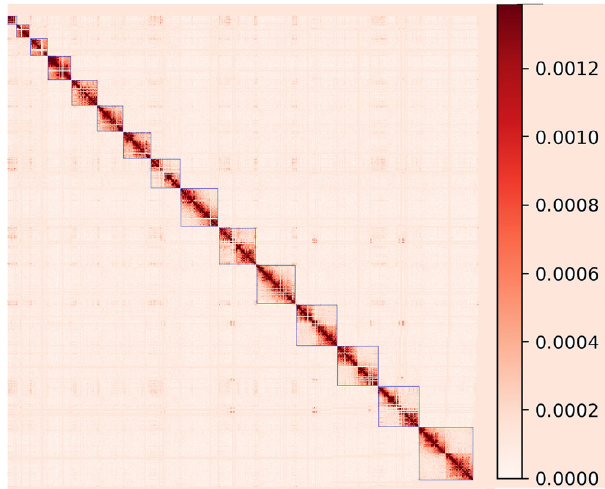
Table 3 Annotated features of American mink